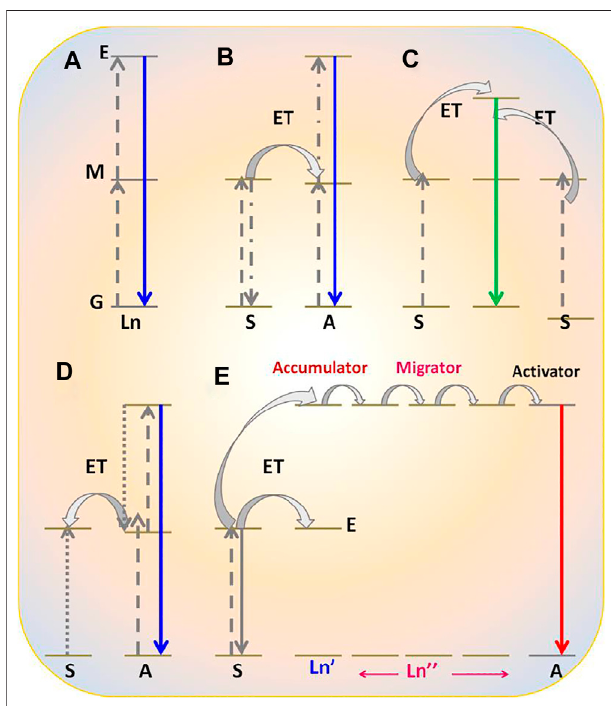
FIGURE 2 | Upconversion photophysical processes shown by RE 3+ - doped nanomaterials: (A) excited state absorption; (B) energy transfer upconversion; (C) cooperative energy transfer upconversion; (D) photon avalanche; (E) energy migration-mediated